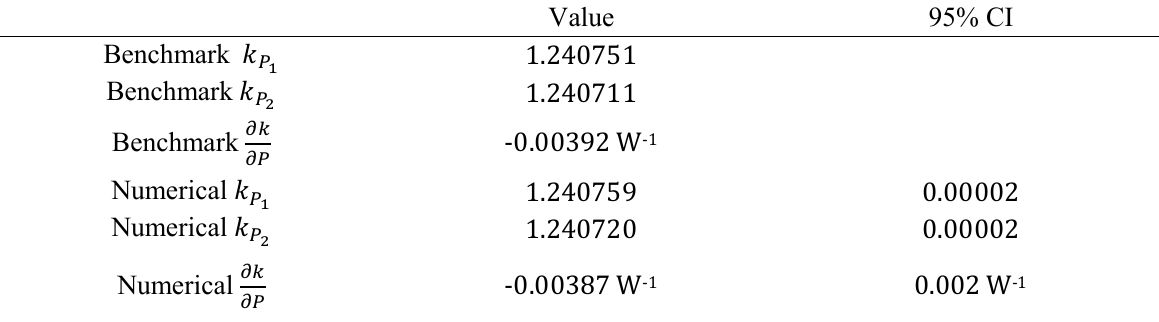
Table 2. Results for power reactivity coefficient